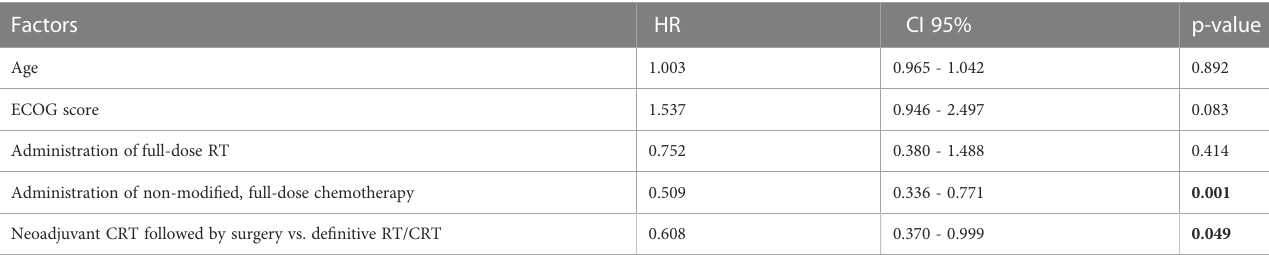
TABLE 3A Multivariate analysis of clinical parameters regarding overall survival (OS) of esophageal SCC in elderly patients after de fi nitive or neoadjuvant CRT/RT. Factors